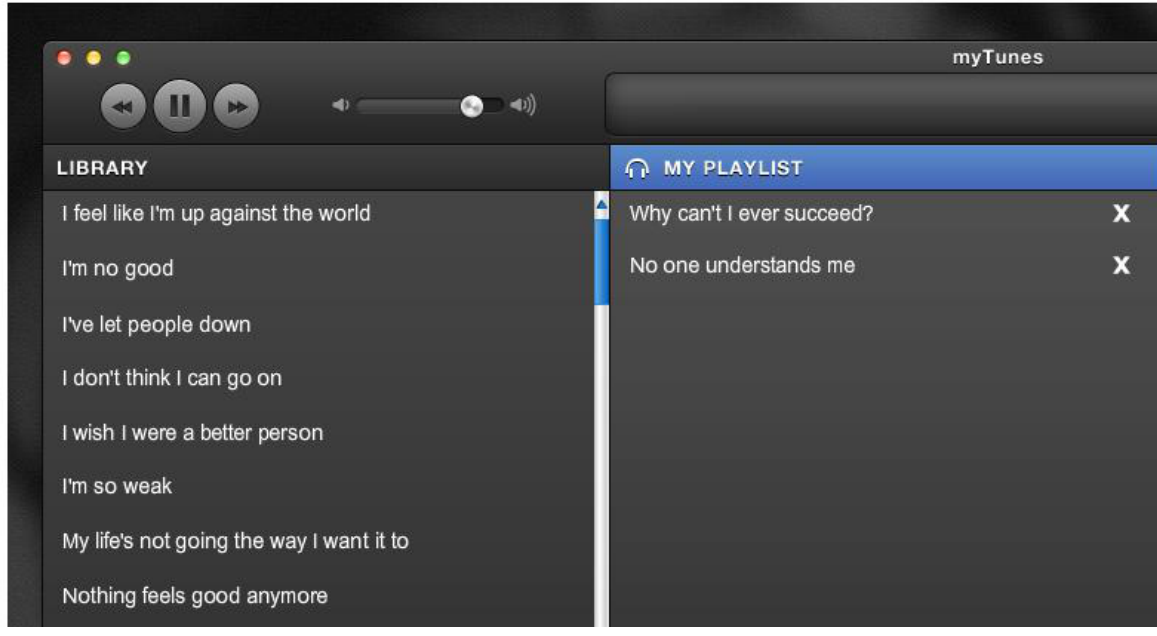
Figure 3. Interactive exercises - Thoughts are not facts.